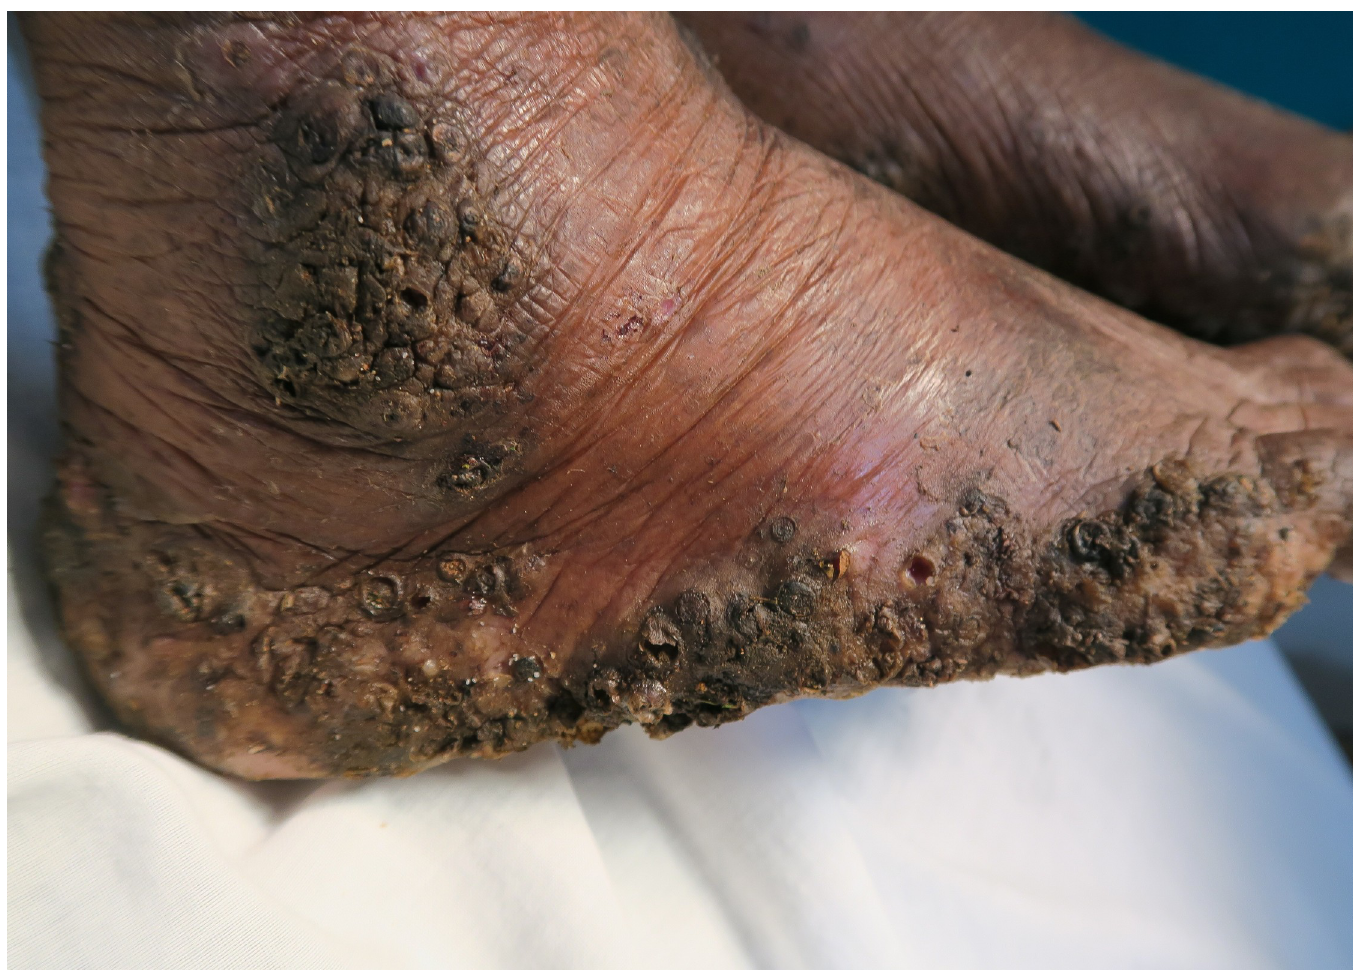
Fig 2. Lateral rim of right foot of the same patient as in Fig 1. Several layers of embedded sand fleas are located on top of each other. A larger cluster of parasites is located at the ankle.